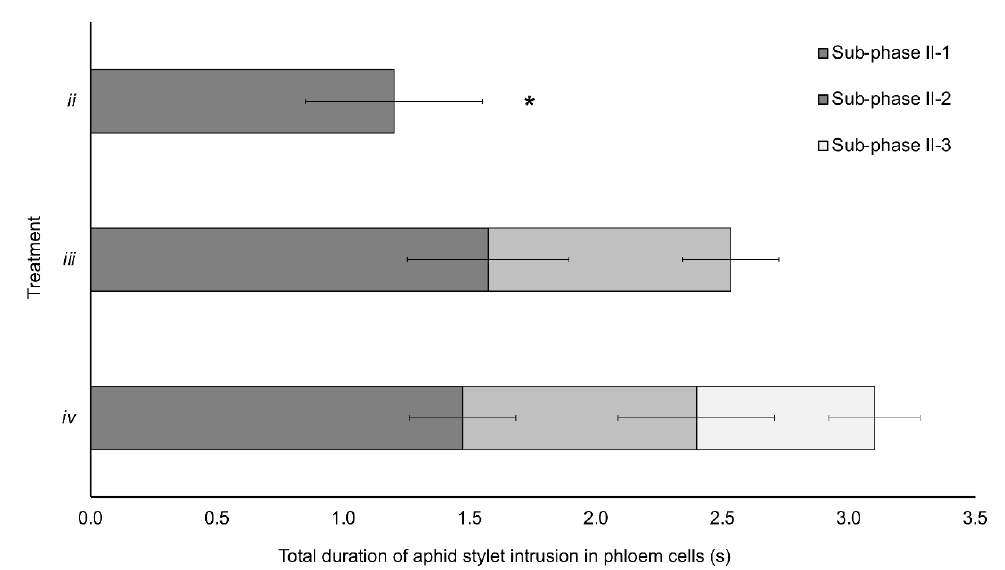
Figure 2. Duration of the different phloem-pd subphases in the three treatments from EPG recordings of aphids producing BYV infection during recorded acquisition access period by EPG (either plant A or both A and B plants). For treatment ii ( n = 9), only subphase II-1 was recorded; for treatment iii ( n = 10), both subphases II-1 and II-2 were recorded, and the three subphases (II-1, II-2 and II-3) were recorded in treatment iv ( n = 11) (complete phloem-pd). Asterisk stands for significant differences according to a Student’s t test ( p <